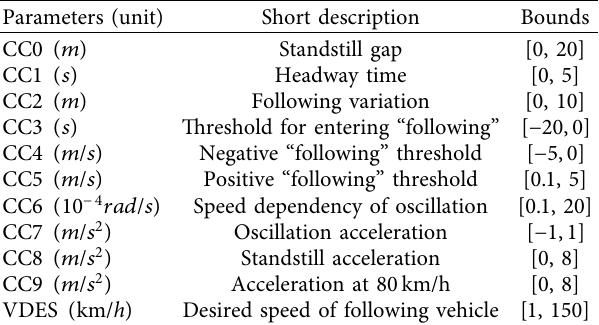
Figure 5: Speed and position curves from a typical car-following event. Table 7: Calibration parameters of the Wiedemann 99 car-fol- lowing